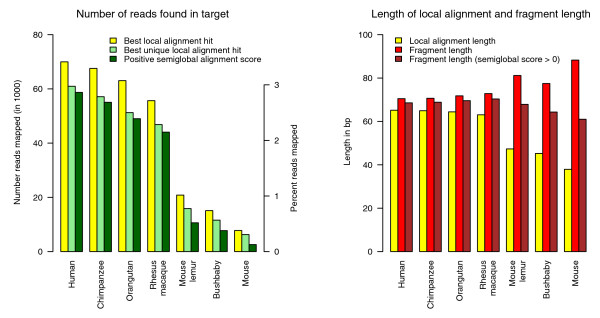
Number of aligned ancient DNA fragments and average sequence length. Properties of Mega BLAST alignments of ancient DNA sequences from a Neandertal fossil to genome sequences of increasing divergence. Left panel: number of reads with a best hit to the genome sequence and not to the GenBank nonredundant and environmental databases (yellow). Subset of reads with one unique best hit to the reference genome (light green). Subset of reads with one unique best hit to the reference genome that can be fully aligned with a positive alignment score (dark green). Right panel: Average length of best local alignments (yellow), average length of fragments with a unique best local alignment (red), average length of fragments with a positive score when fully aligned to reference genome (brown).